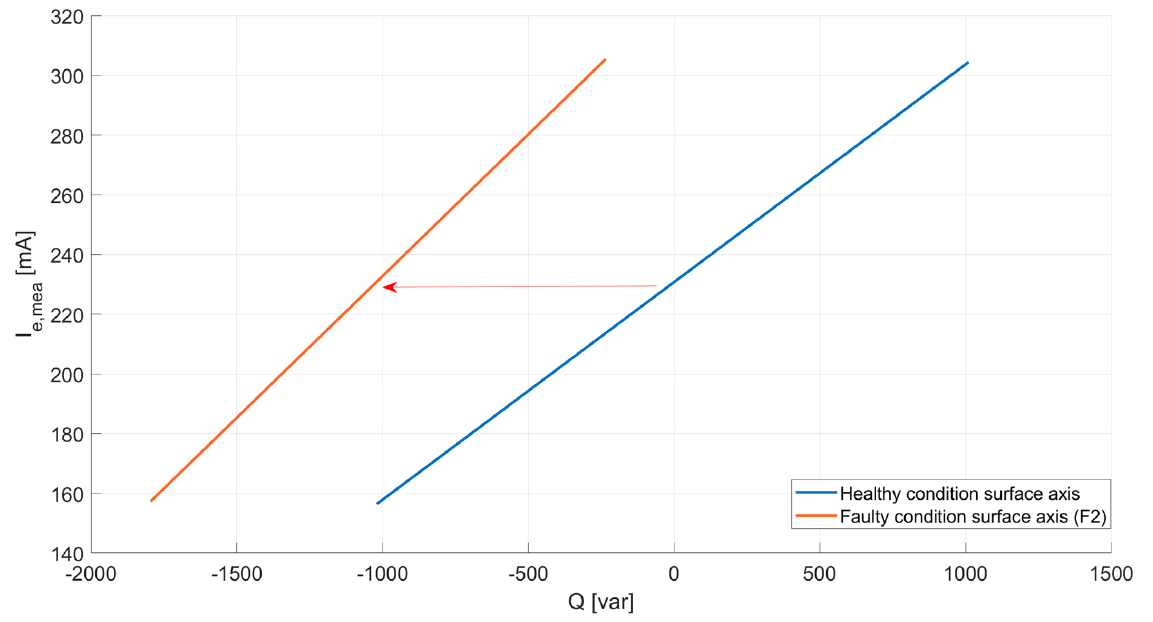
Machines 2023 , 11 , x FOR PEER REVIEW 18 of 22 Figure 16. Experimental results. Representation of I e,mea healthy and faulty conditions (F2: shorted- Figure 16. Experimental results. Representation of I e,mea healthy and faulty conditions (F2: shorted- diode fault with R f = 6 Ω ), surface axis for P = 1500 W at U = 400 V. diode fault with R f = 6 Ω ), surface axis for P = 1500 W at U = 400 V.